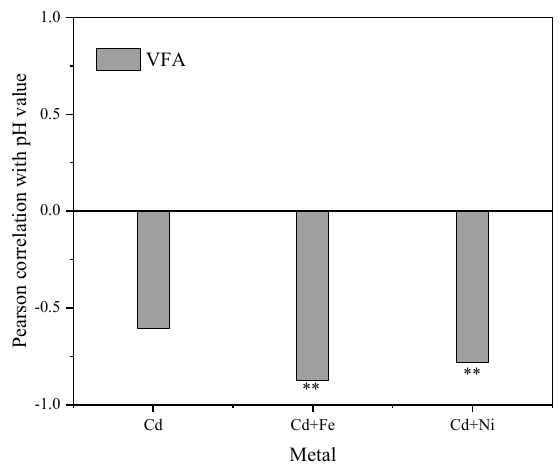
Figure 5. Relationships between pH values and VFA concentrations during the fermentation. **, p < 0.01.